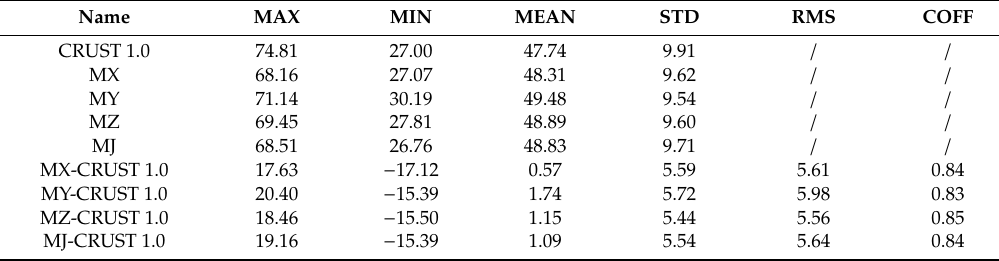
Figure 5. Moho depths provided by the CRUST 1.0. The major tectonic elements (see Figure 1) are overlain on the map for assist analysis. The red lines are the national borders. Table 1. Statistics of Moho depths from various methods and their differences (unit: km), COFF denotes the correlation coefficient (unitless). MAX, MIN, MEAN, STD, and RMS are the maximum, minimum, average, standard deviation and root mean square, respectively. “/” denotes none.